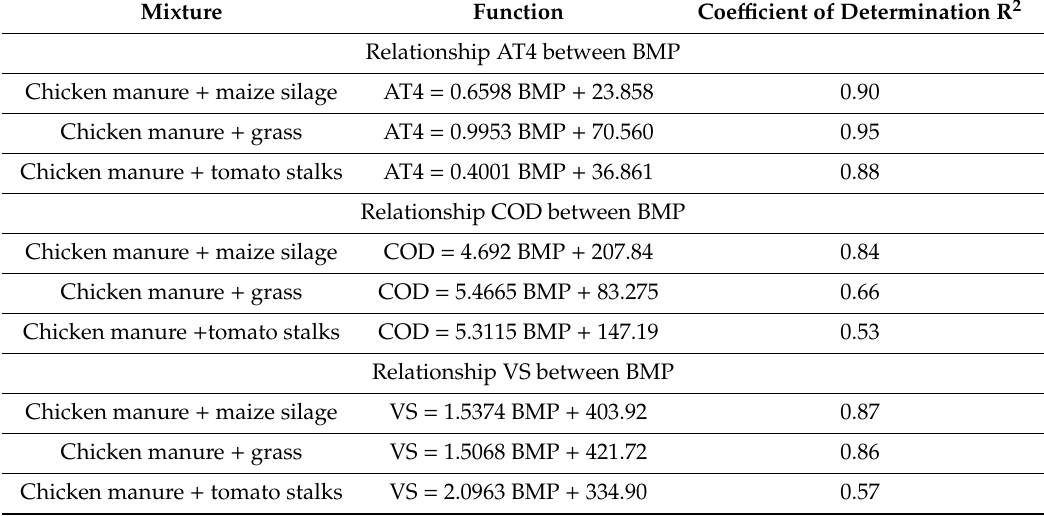
Table 2. The functions describing the correlations between the AT4, COD, and VS indices, and the BMP .